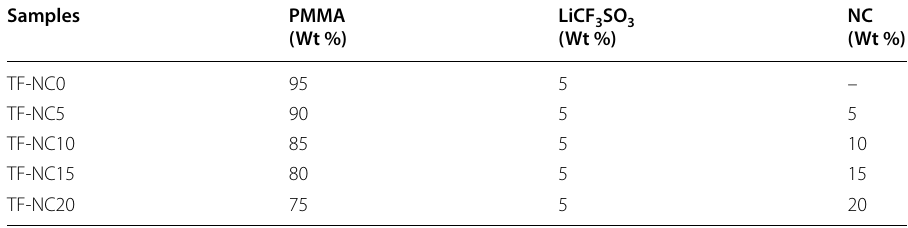
Table 1 Composition of PMMA, lithium triflate (TF), and nanochitosan (NC)